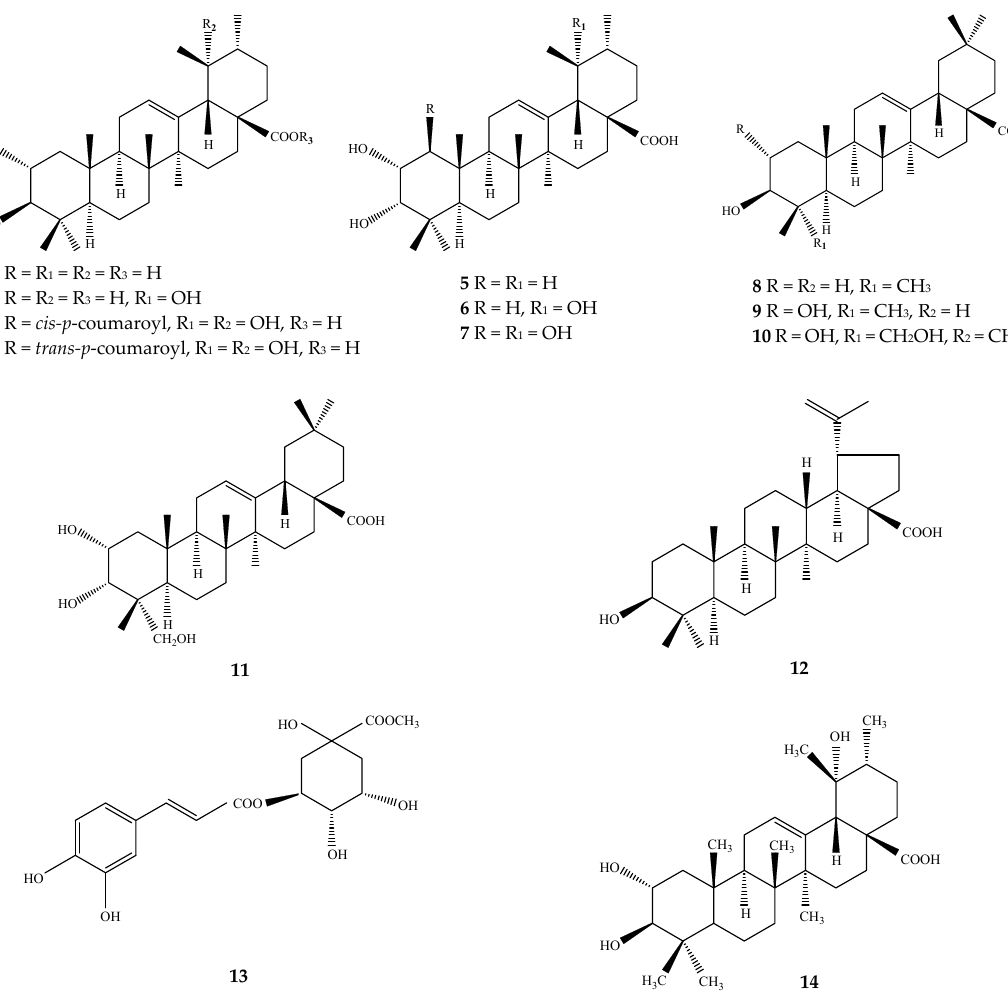
Figure 1. Structures of chemical compounds 1 – 14 . 1 : ursolic acid; 2 : corosolic acid; 3 : 3- O - cis - p - coumaroyltormentic acid; 4 : 3- O - trans - p -coumaroyltormentic acid; 5 : 3-epicorosolic acid; 6 : euscaphic acid; 7 : 1 β -hydroxyeuscaphic acid; 8 : oleanolic acid; 9 : maslinic acid; 10 : methyl arjunolate; 11 : 2 α ,3 α ,23-trihydroxyolean-12-en-28-oic acid; 12 : betulinic acid; 13 : methyl chlorogenic acid; 14 : tormentic acid.